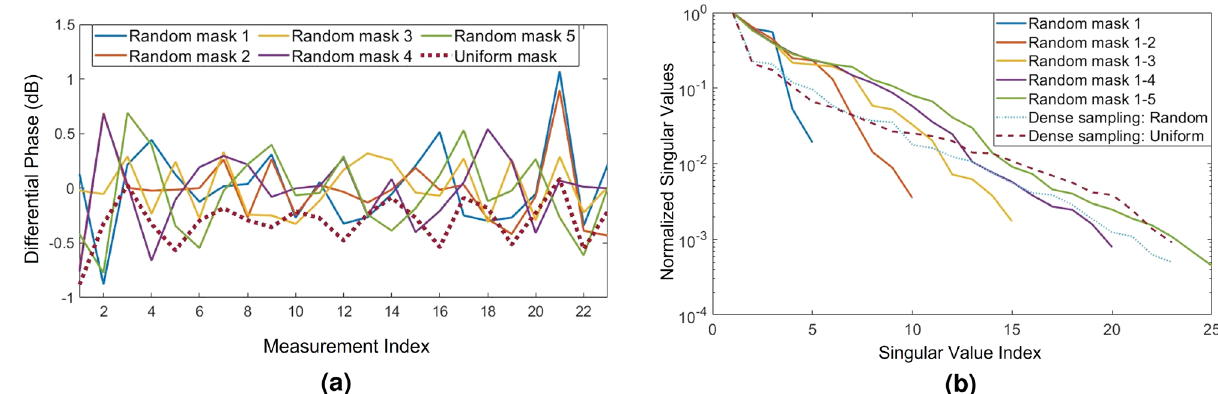
Figure 6. ( a ) Differential phase for uniform and different random capacitor combinations (masks) for 10 ◦ incident angle. ( b ) Normalized singular values of the sensing matrix for a sparse sampling metasurface (with different numbers of random masks) in comparison to densely sampled uniform (and random)